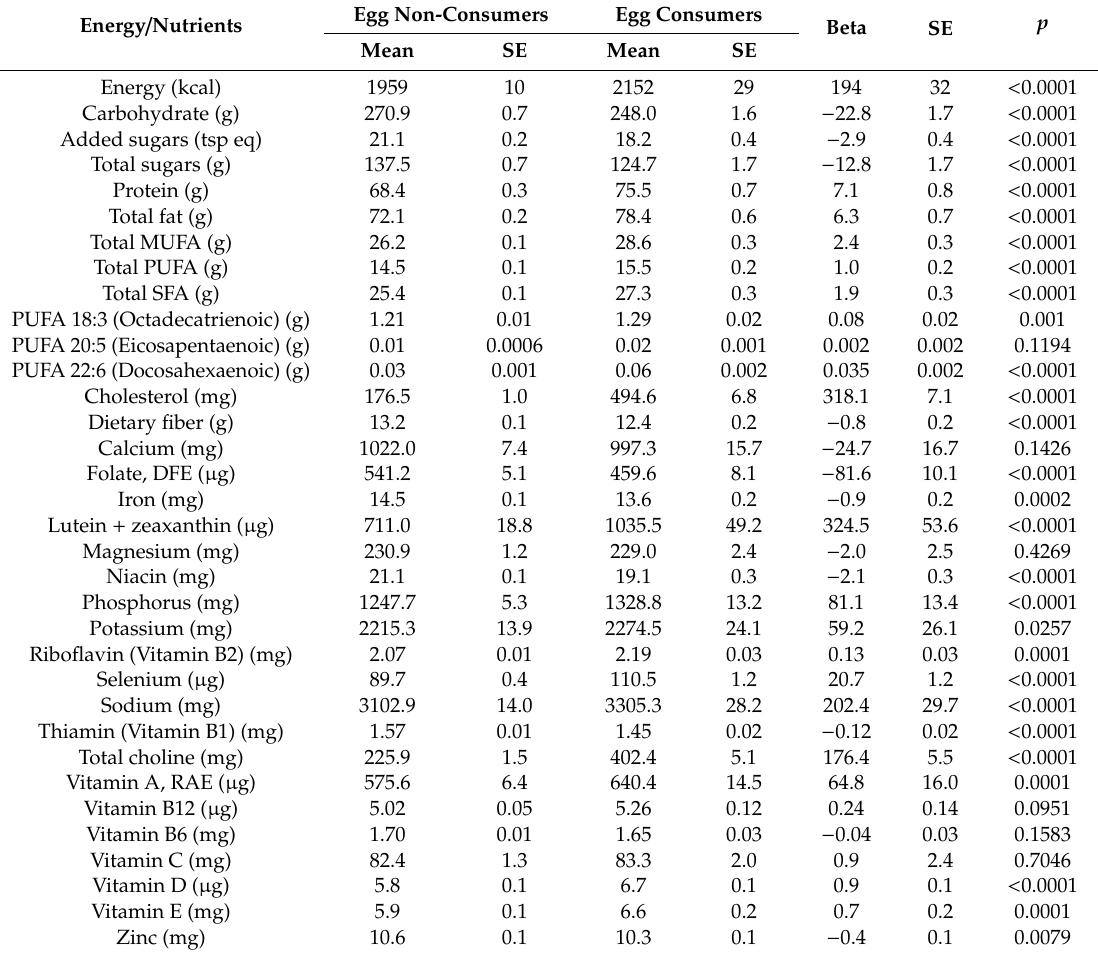
Table 2. Day 1 nutrient and energy intakes in egg consumers vs. egg